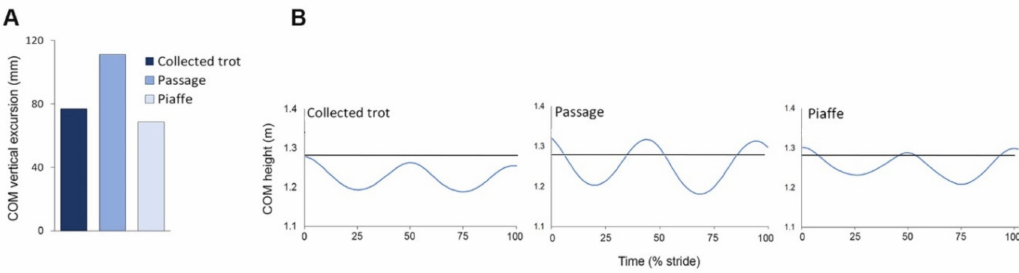
Figure 5. ( A ) Vertical excursion of the center of mass per stride during collected trot, passage, and pia ff e. ( B ) Height of the center of mass during a complete stride starting and ending at hind contact for collected trot ( left ), passage ( middle ) and pia ff e ( right ). The horizontal line represents standing height of the center of mass